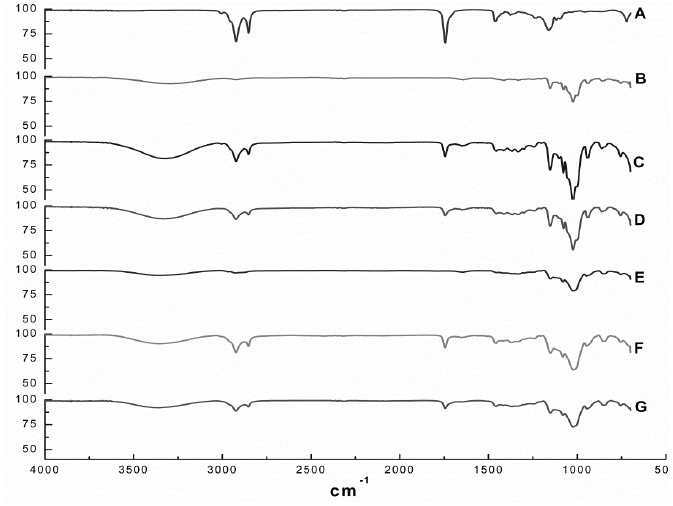
Figure 2. FT-IR spectra of E. oleracea oil (EOO) ( A ), β -cyclodextrin ( B ), EOO- β -cyclodextrin